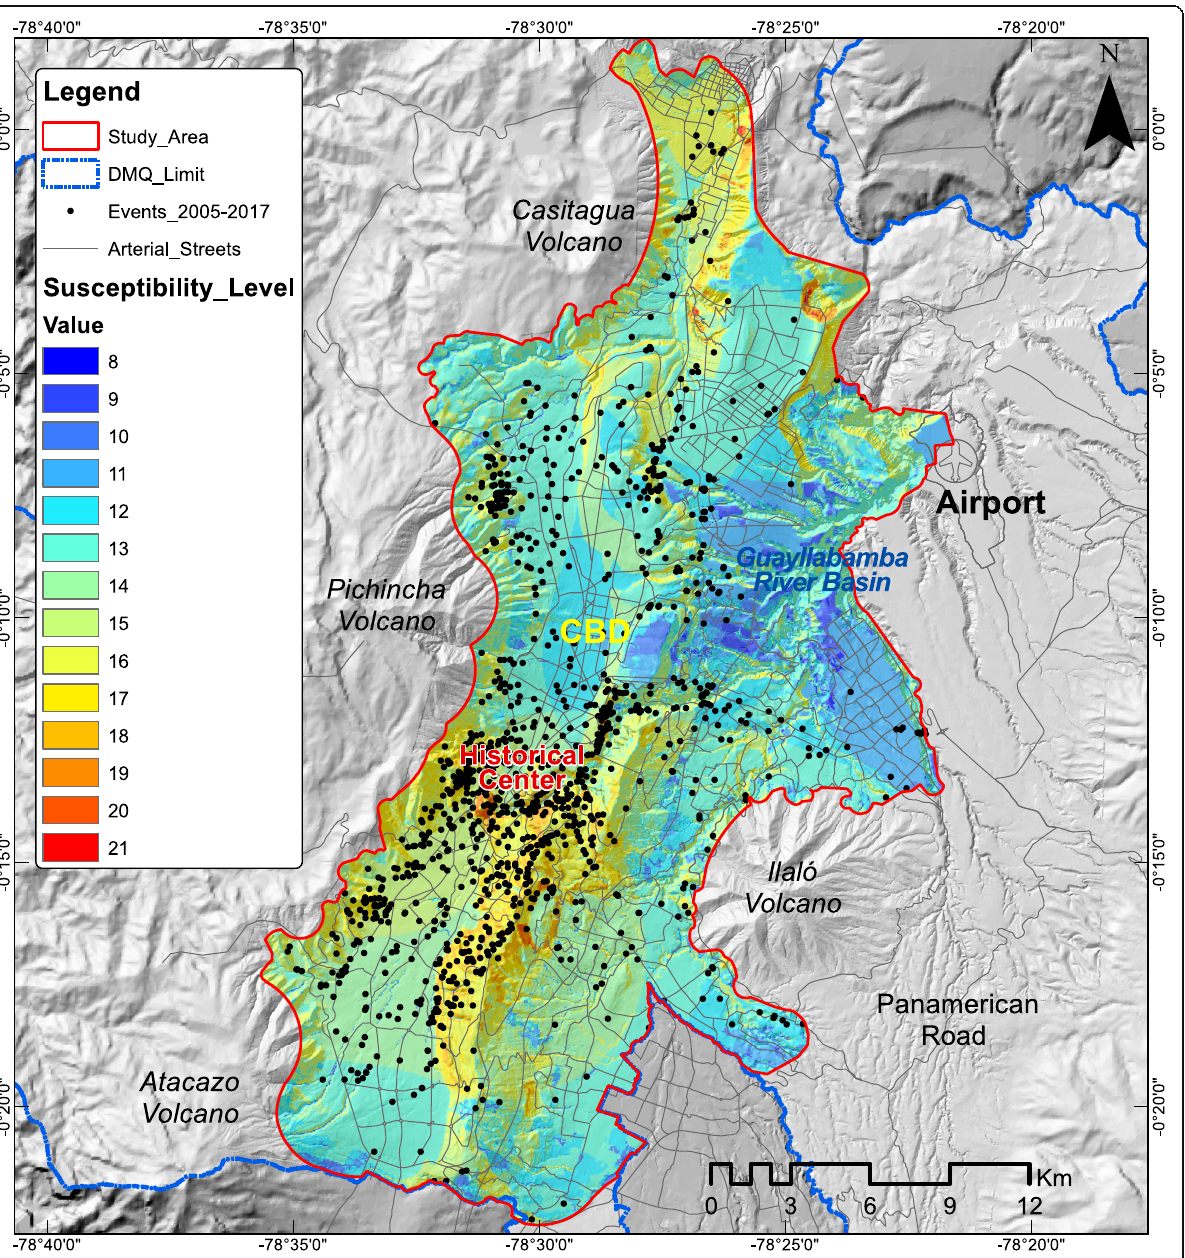
Fig. 2 Landslide susceptibility map for Quito including 2005 – 2017 event spots. Data Source: Quito Municipality MDMQ. Legend: Study Area (red line), Landslide Events during the 2005 – 2017 period (black dots), Arterial Streets network (grey continuous lines), the Metropolitan District of Quito jurisdictional limit (dashed blue line) and eight to 21 landslide susceptibility levels (blue-yellow-red color